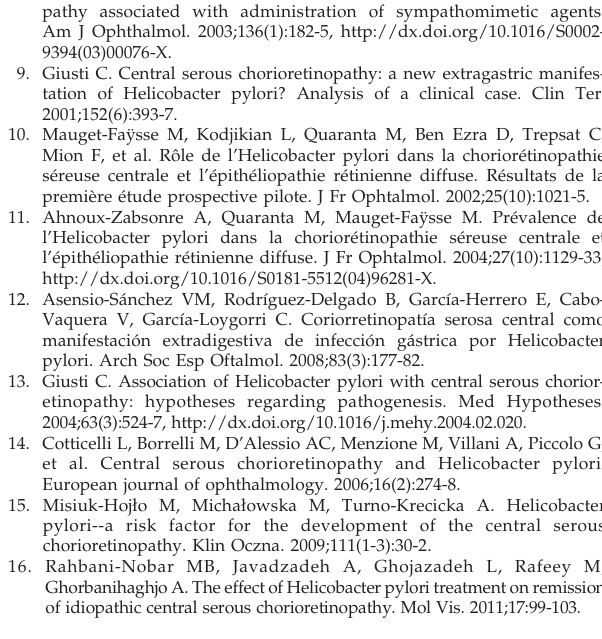
Figure 3 - A patient with a six-month history of CSC and macular serous detachment (A-B). Fluorescein angiography showed RPE changes and a juxtafoveal leak (arrow), precluding regular laser treatment (C-D). The serous detachment improved after anti-HP treatment (E-F), and fluorescein angiography showed prominent resolution of the leakage with persistence of the RPE changes (G- H).